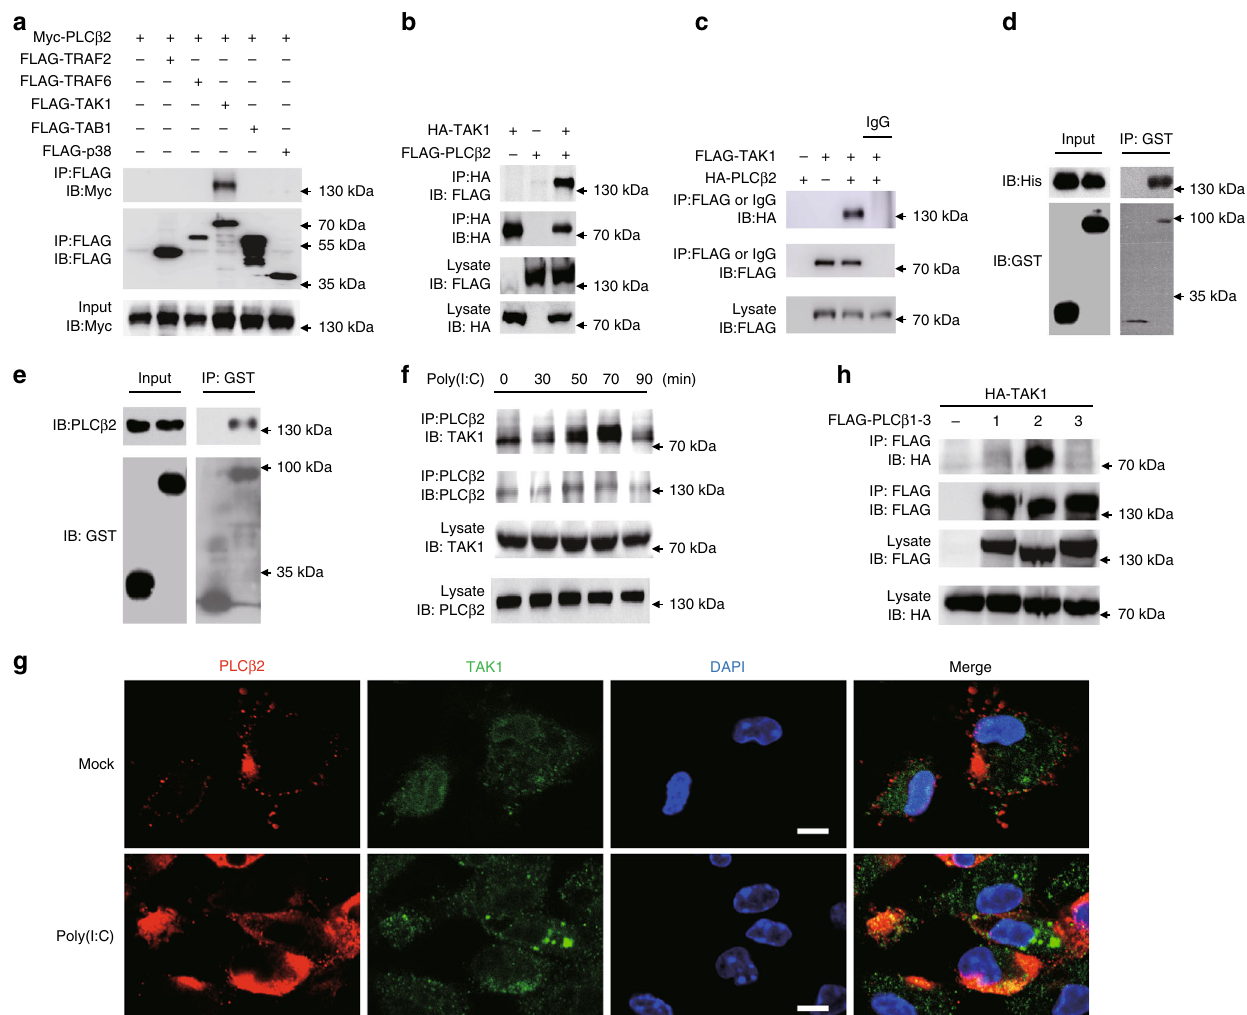
Fig. 3 PLC β 2 interacts with TAK1. a – c IB or immunoprecipitates (IP) of lysates from HEK293T cells transfected with various plasmids as indicated. d In vitro GST precipitation assay of TAK1 and PLC β 2. e Precipitation of endogenous PLC β 2 from RAW264.7 cells expressing GST or GST-TAK1. f Endogenous interaction of PLC β 2 with TAK1 in poly(I:C)-treated primary macrophages. g Confocal analysis of colocolization of TAK1 and PLC β 2 in peritoneal macrophages stimulated with poly(I:C) for 4 h. Scale bar, 5 μ m. h IB or IP of lysates from HEK293T cells transfected with FLAG-tagged PLC β 1-3 and HA- tagged TAK1. Data are representative of three experiments with at least three independent biological replicates ( n = 3 cultures in f , g